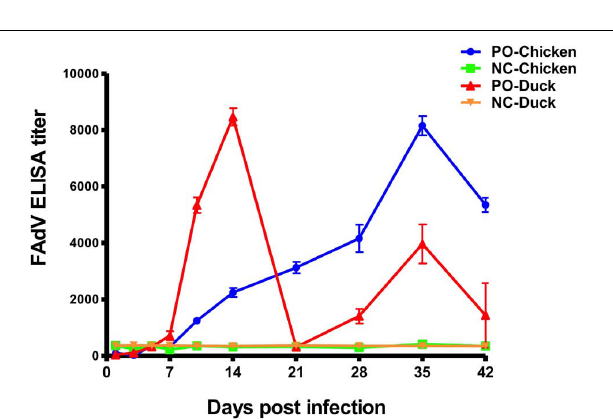
FIGURE 6 | Antibody responses of experimentally infected SPF chickens and ducks. The dynamic curves of antibody response showed only one peak in chickens (Blue curve) but two peaks in ducks (Red curve), and the peak in chickens occurred later than the early peak of ducks and approximately at the same time as the late peak in ducks. All birds in the control groups showed negative antibody